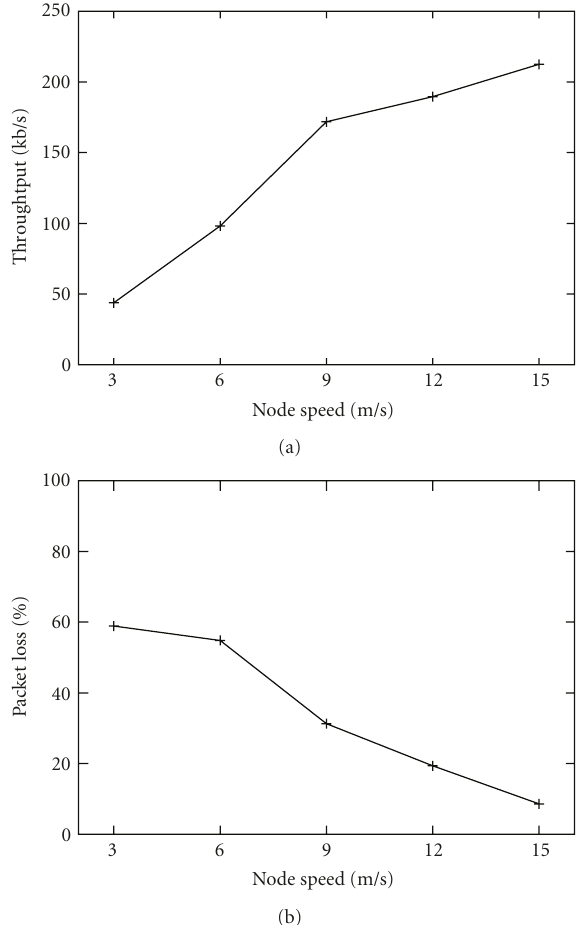
Table 5: Percentage of the simulation time when exists a route between both laptops. Figure 28: Throughput and packet losses with a standard videocall in a scenario with